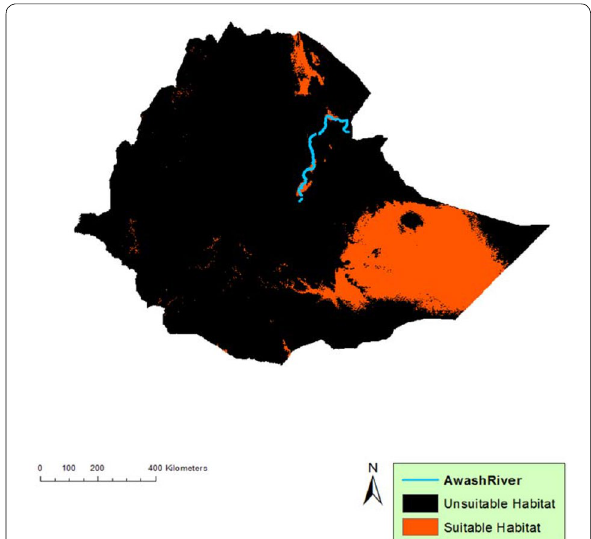
Fig. 5 Habitat suitability for distribution of Prosopis in Ethiopia using combined (EO and climate parameters) and MaxEnt model